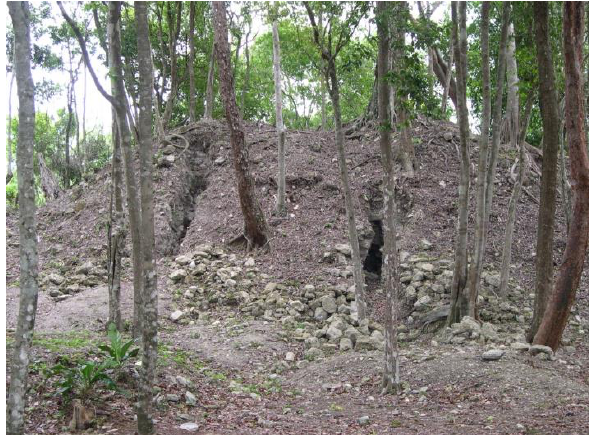
Figure 1. Looting trenches in an archaeological mound at Tzikín Tzakán, Petén, Guatemala. (Photo G. Muñoz